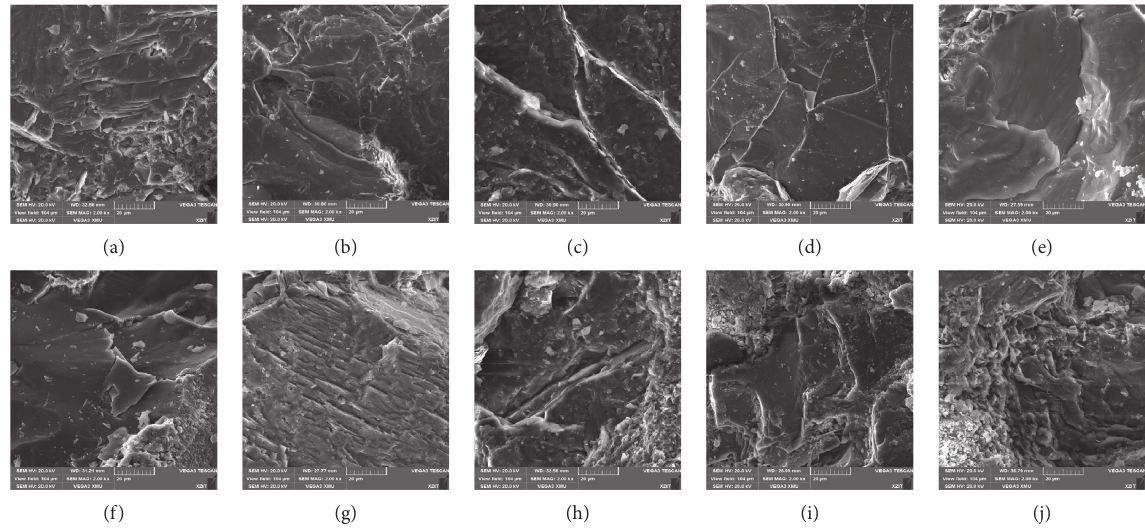
Figure 11: The SEM images under different brittleness and loading strain rate conditions (2000 times). (a) _ ε � 63s − 1 ; BI � 0 . 81. (c) _ ε � 63s − 1 ; BI � 0 . 86. (d) _ ε � 63s − 1 ; BI � 0 . 92. (e) _ ε � 63s − 1 ; BI � 1. (f) _ ε � 63s − 1 ; BI (b) _ ε � 63s − 1 ; BI 3 3 3 3 � 0 . 82. (h) _ ε � 116s − 1 ; BI � 0 . 82. (i) _ ε � 134s − 1 ; BI � 0 . 82. (j) _ ε � 156s − 1 ; BI � 0 . BI 3 3 3 3